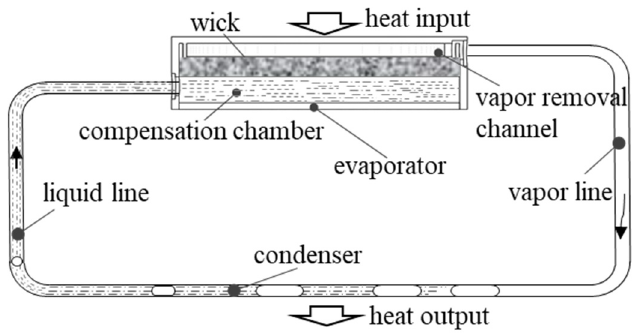
Figure 1. LHP’s composition and working principle.